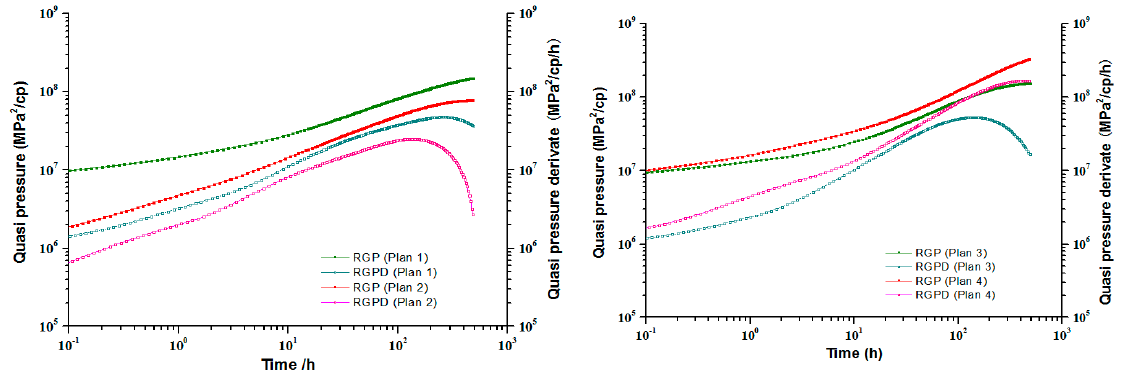
Figure 7. BHP changes during production and shut-in of L2 well.